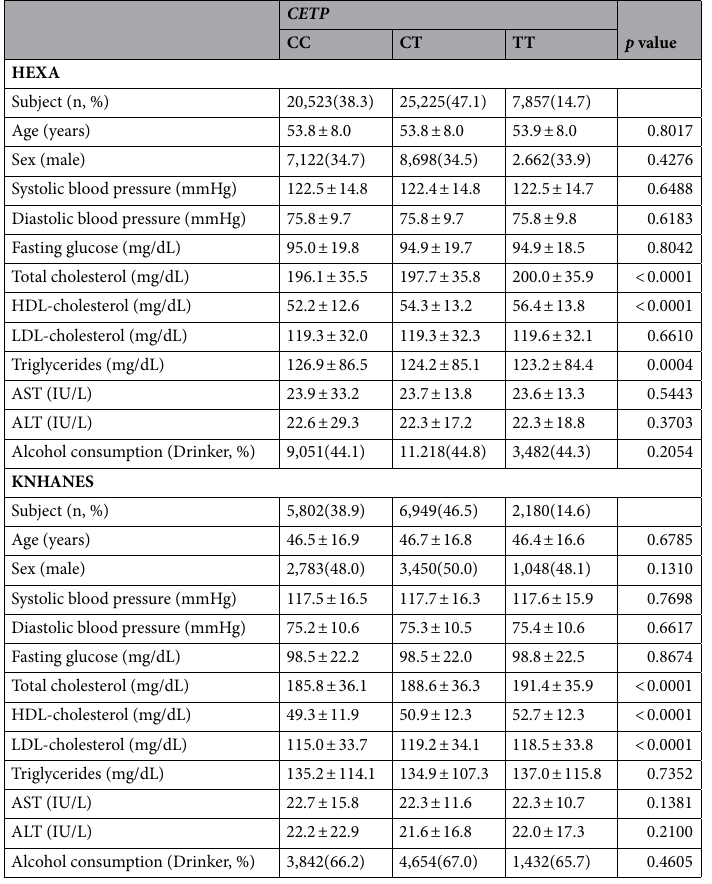
Table 2. General characteristics of subjects according to CETP genotype in HEXA and KNHANES. All data except alcohol consumption and sex are represented as means ± standard deviation. General linear models and chi-square tests were used to determine differences between CETP genotype. HDL high-density lipoprotein, AST aspartate aminotransferase, ALT alanine